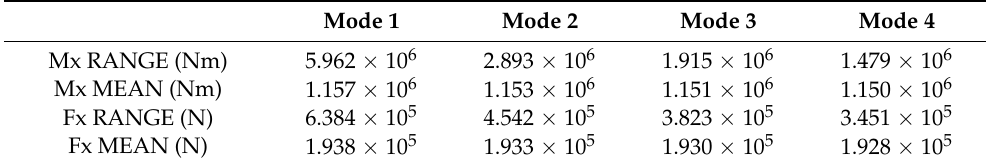
Table 4. The tower x-direction load indicators.